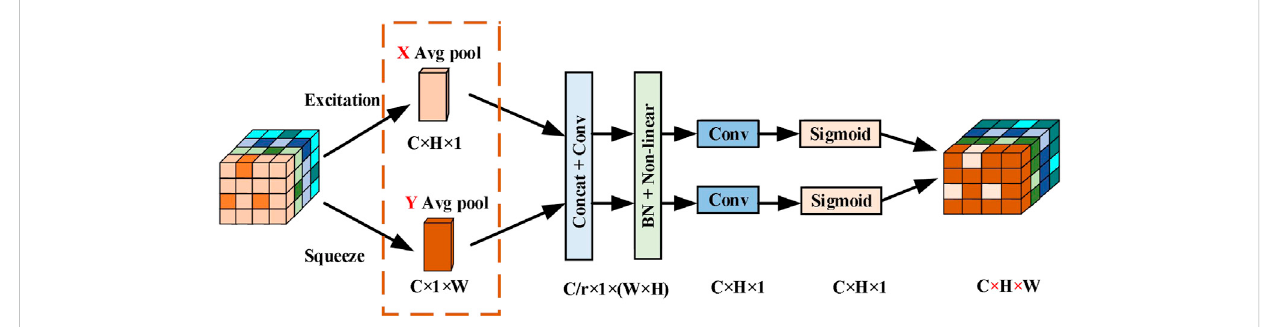
FIGURE 5 The module of channel space attention.